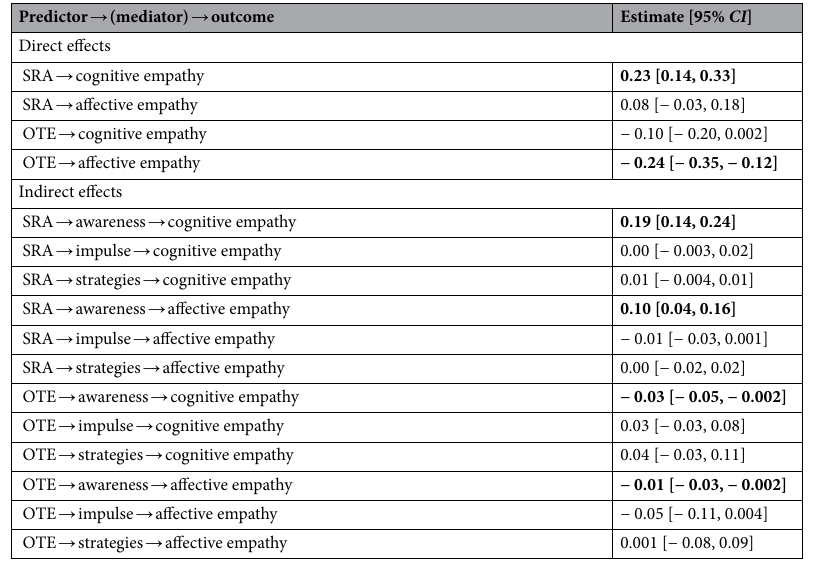
Table 2. Direct and indirect effects between mindfulness and empathy with aspects of emotion regulation as mediators. SRA = Self-regulated Attention; OTE = Orientation to Experience; awareness = emotional awareness; impulse = impulse control; strategies = emotion regulation strategies. Numbers represent standardized effect estimates, alongside their bias-corrected bootstrap confidence intervals ( CI s). Significant ( p < 0.05) effects are printed boldface. Meditation experience and participants’ sex were included as background confounders (see Table